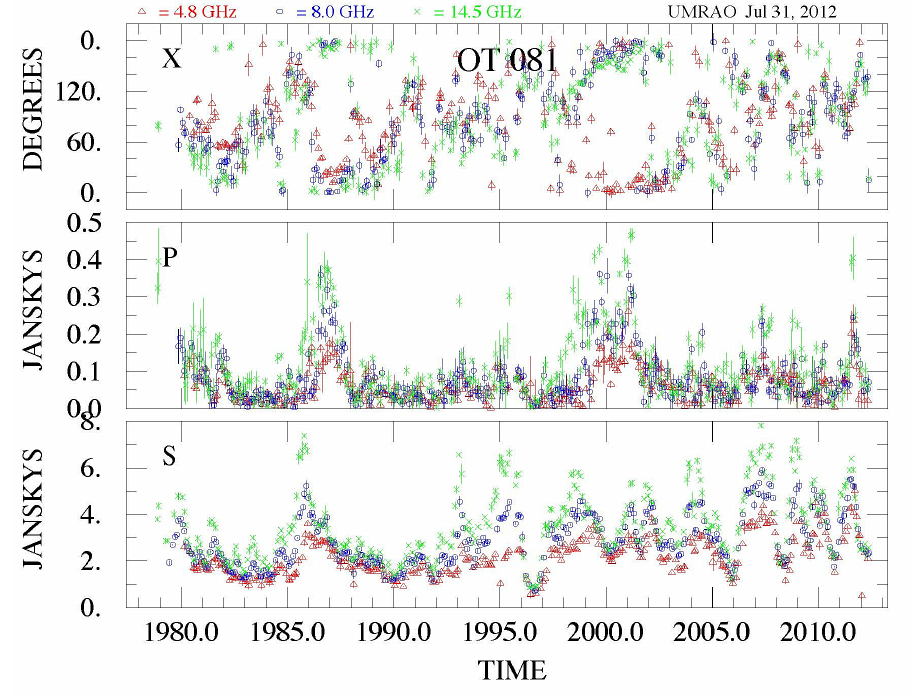
Figure 1. From bottom to top: monthly-averaged total flux density, linear polarization, and electric vector position angle observations for OT 081 (1749 + 096) from the University of Michigan blazar variability program (UMRAO). The three centimeter-band frequencies are symbol and color coded as denoted at the top